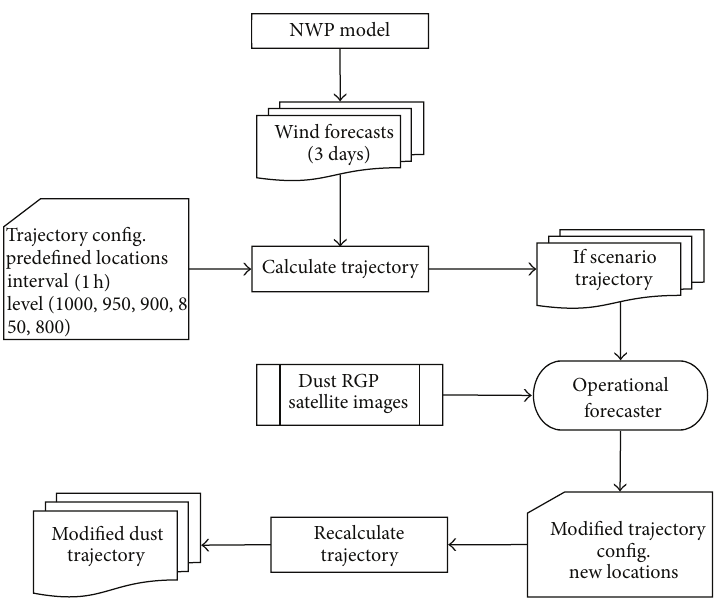
Figure 2: Data flow diagram of the